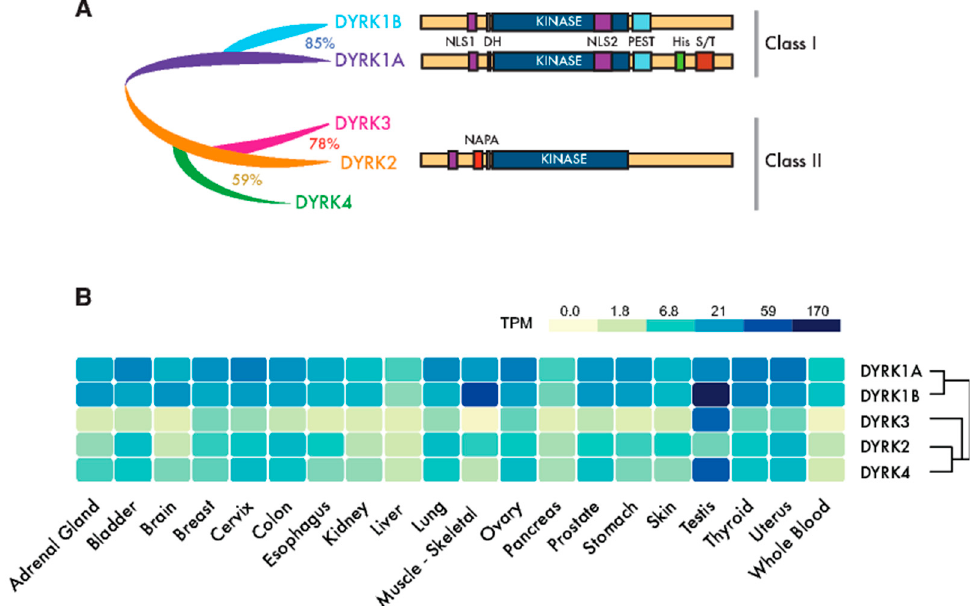
Figure 1. Dual-specificity tyrosine-regulated kinase (DYRK) protein kinases: primary structure and expression. ( A ) Scheme of the mammalian family of DYRKs, indicating their phylogenic relationships, degree of homology and protein domains. The catalytic domain (KINASE) and the DYRK homology box (DH) are common to all members of the family. Class I DYRKs have two nuclear localization signals (NLSs) (NLS1 and NLS2) and a proline-, glutamic acid-, serine- and threonine-rich (PEST) motif. DYRK1A also includes a tract of 13 consecutive histidine residues (His) and a region enriched in serine / threonine residues (S / T) at the C-terminus. Class II DYRKs have a common structure, with the characteristic N-terminal autophosphorylation accessory (NAPA) domain at the N-terminus. In the case of DYRK2 and DYRK4, functional NLSs have been described within the noncatalytic N-terminus. ( B ) The expression of human DYRKs based on the Genotype-Tissue Expression (GTEx) data represented as the median TPMs (transcripts per million: GTEx Analysis Release V8, www.gtexportal.org / home, dbGaP Accession phs000424.v8.p2). Tissues represented in the tumor data in Table S1 were chosen (brain: cortex; cervix: ectocervix; colon: sigmoid colon; esophagus; mucosa, kidney: cortex; skin: suprapubic—not sun-exposed).